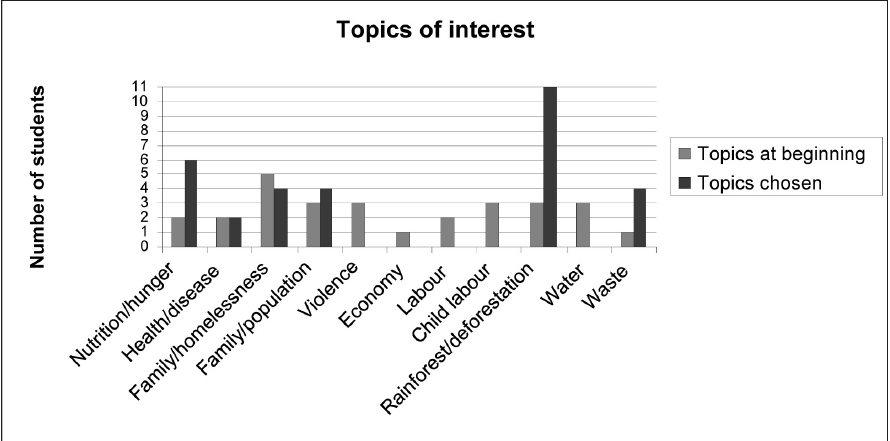
Figure 3: Topics of students’ interest